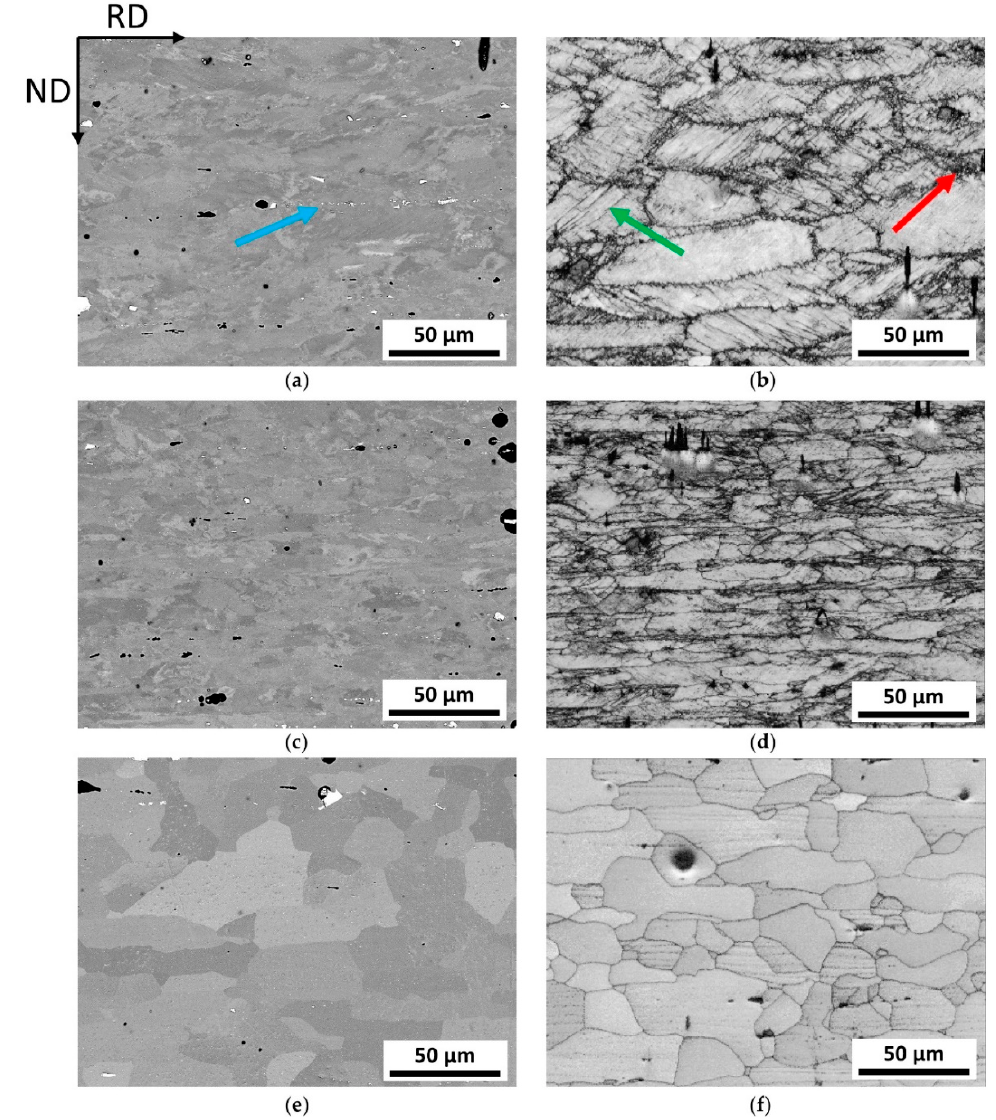
Figure 4. Microstructure evolution of the laboratory processed EN AW-5182 plotted in the TD-plane; ( a , c , e ) show ( a ) backscattered electron (BSE) images of the hot-rolled, ( c ) cold-rolled (after IA), and ( e ) soft annealed state, respectively; ( b , d , f ) show ( b ) band contrast maps of the hot-rolled, ( d ) cold-rolled (after intermediate annealing (IA)), and ( f ) soft annealed state, respectively. Table 3. Microstructural parameter for laboratory and industrially produced EN AW-5182 sheets. Scale of